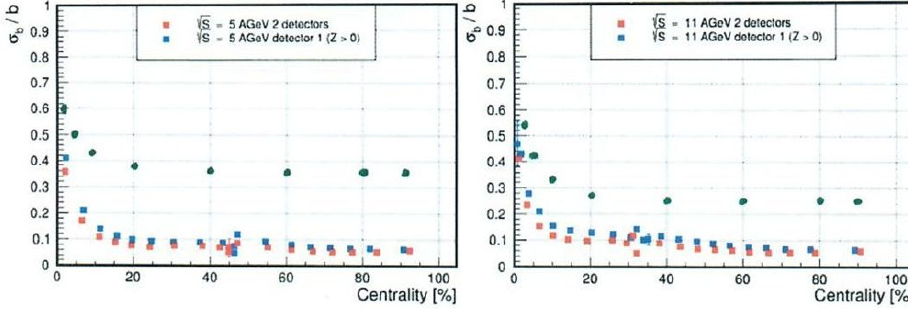
Figure 3. Resolution of impact parameter obtained in separate bins of the energy depositions in FHCal for beam energy 2.5 GeV (left) and 5.5 GeV (right). Blue and red points correspond to the